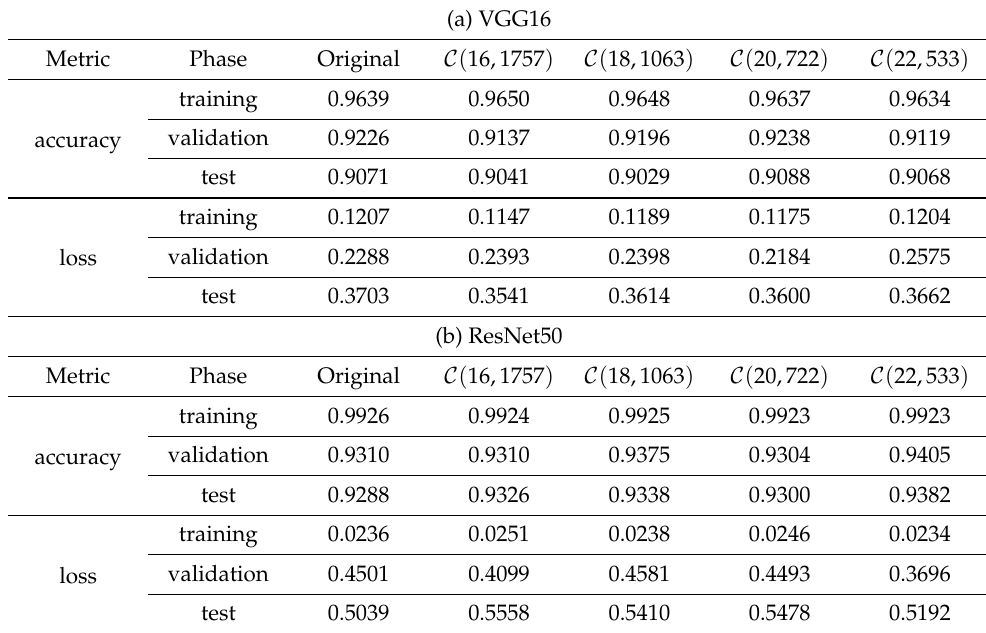
Table 2. Effect of embedding watermark on the original task when k = 128.